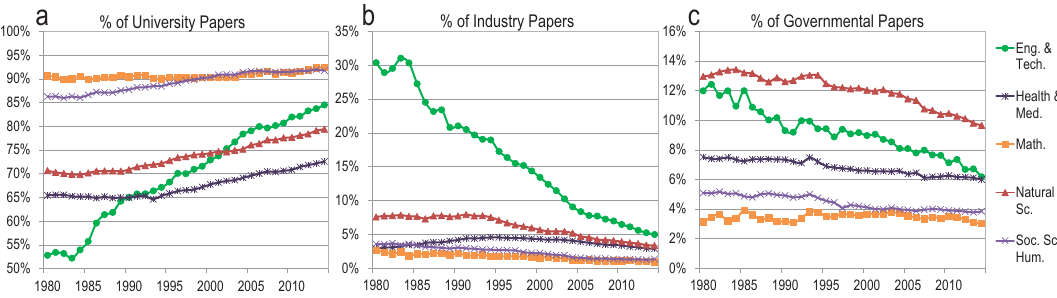
Fig 2. Proportion of world papers authored by(A) Universities, (B) Industries and (C) Governments, by discipline, 1980–2014.